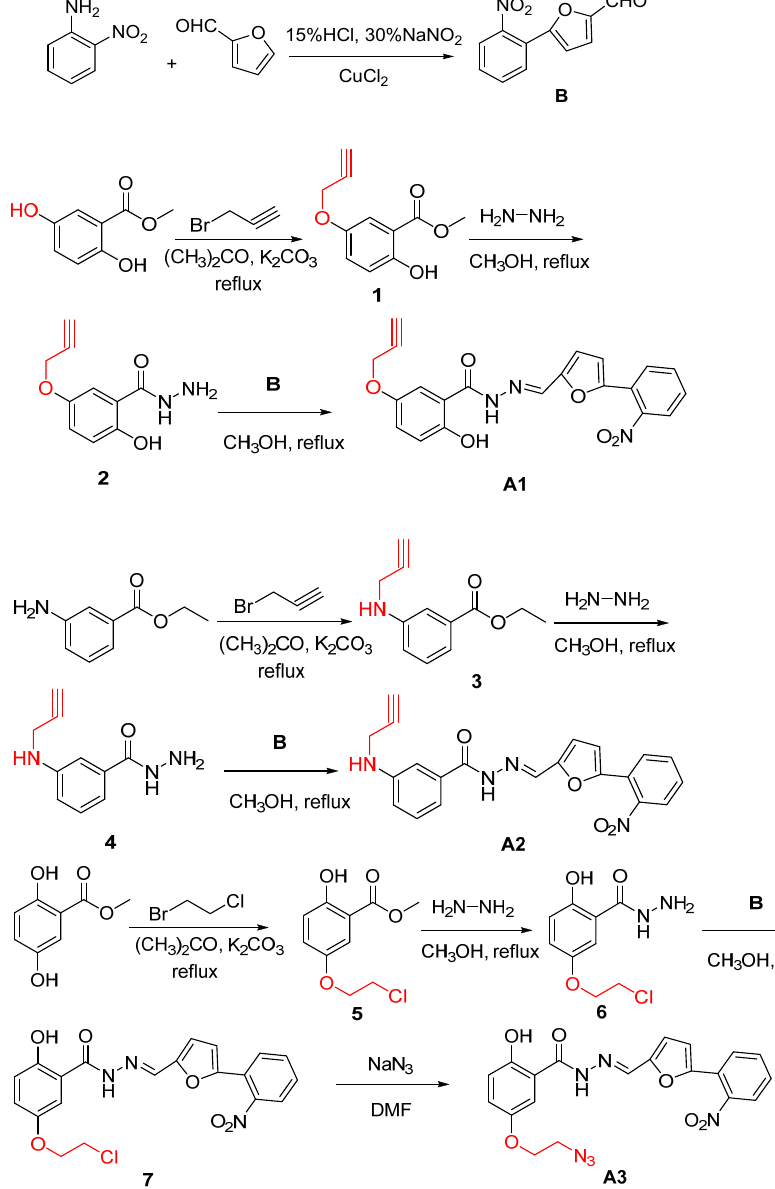
Figure 1. Synthesis routes of compounds A1 – A3 .